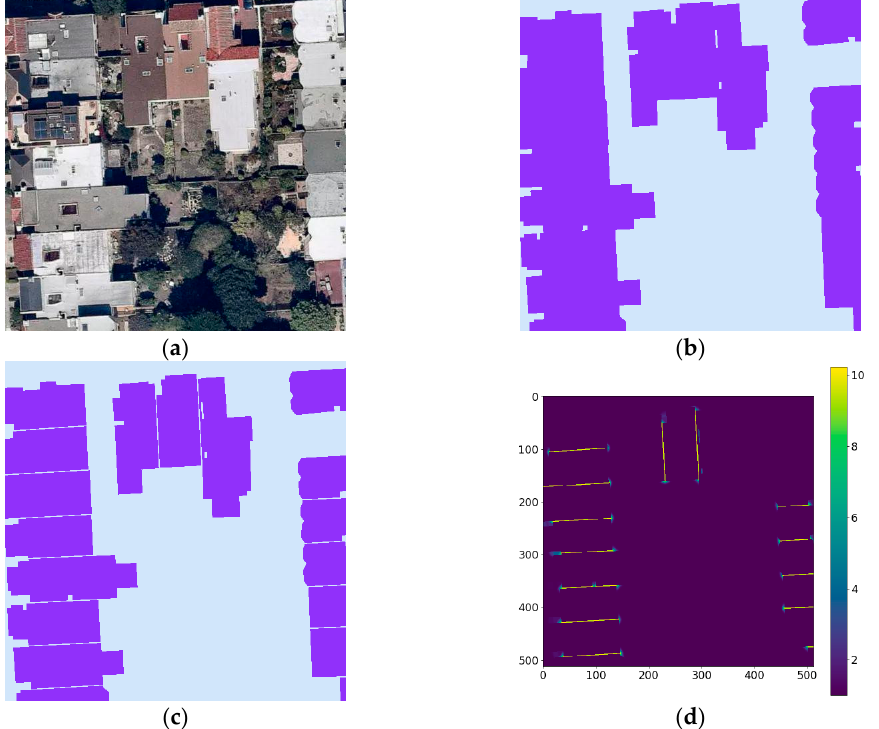
Figure 1. Illustration of the data preparation process. ( a ) Remote sensing image; ( b ) Ground truth mask; ( c ) Ground truth mask after downsizing polygons; ( d ) Spatial weights map.